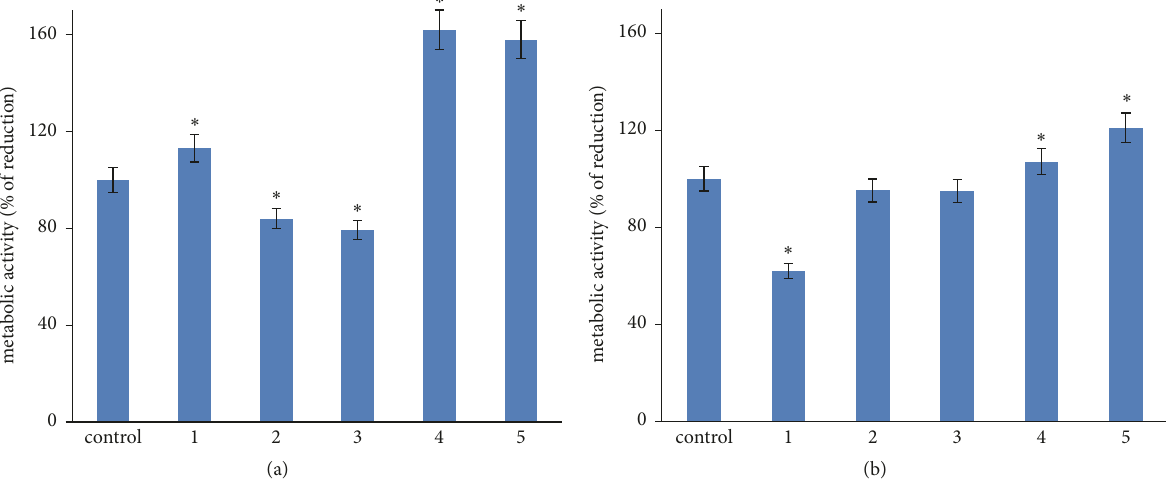
Figure 6: ADSCs metabolic activity in control and experimental groups in 24h (a) and 72h (b) in culture. Deuterium concentration: control: D/H 150 ppm; No. 1: D/H 500.000 ppm; No. 2: D/H 100.000 ppm; No. 3: D/H 10.000 ppm; No. 4: D/H 75 ppm; No. 5: D/H 15 ppm. The results are expressed as mean ± SD (n=6); ∗ : significant differences between the experimental group and the control, p <